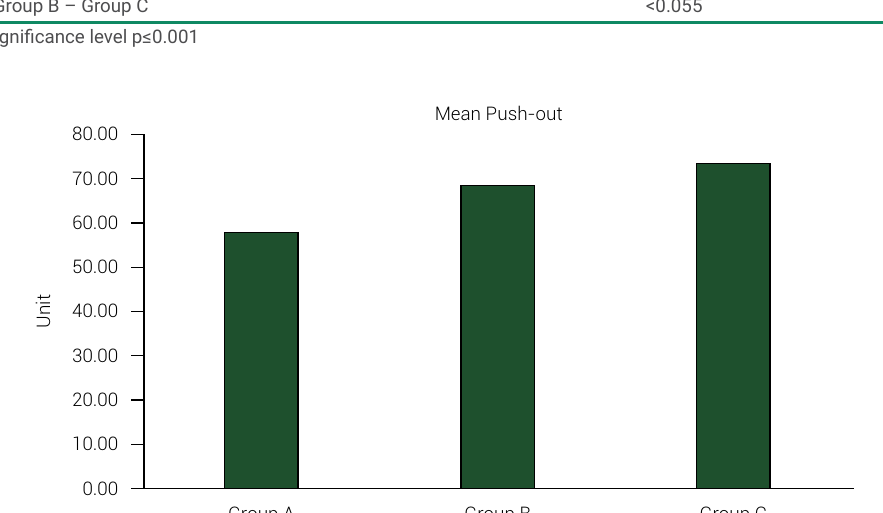
Figure 3. Bar chart representing the mean push-out in the coronal third in the three